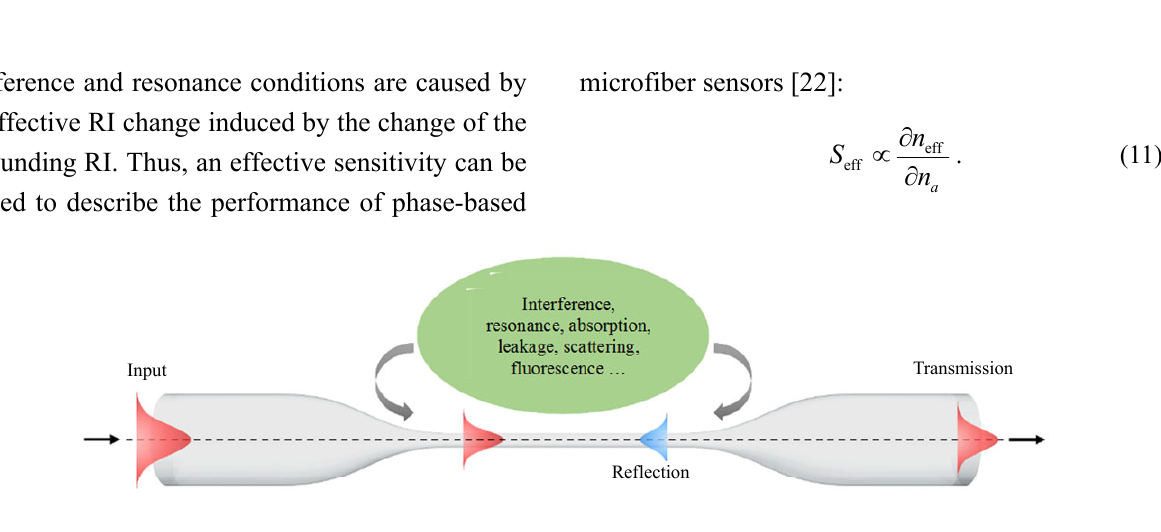
Fig. 7 Basic sensing processes of microfiber-optic sensors. By detecting and analyzing variations in optical phase, intensity, frequency, and polarization of the transmitted and reflected light signals from microfiber structures, the surrounding physical, chemical, and biological parameters can be demodulated regarding the detailed interaction processes. Diverse microfiber structures provide versatile platforms for various physical, chemical, and biological effects with favorable characteristics, such as a small footprint, strong optical confinement, and large evanescent fields. The green ellipse represents the typical physical effects that constitute the operating principles of microfiber-optic sensors.